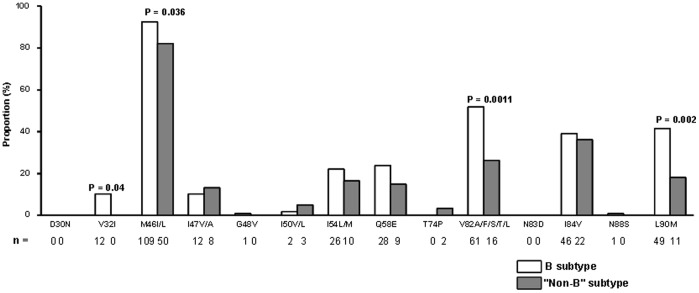
Proportion of protease inhibitors resistance-associated mutations with the L76V mutation in HIV-1 subtype B samples and in HIV-1 “non-B” samples.P-values are indicated only if significant.